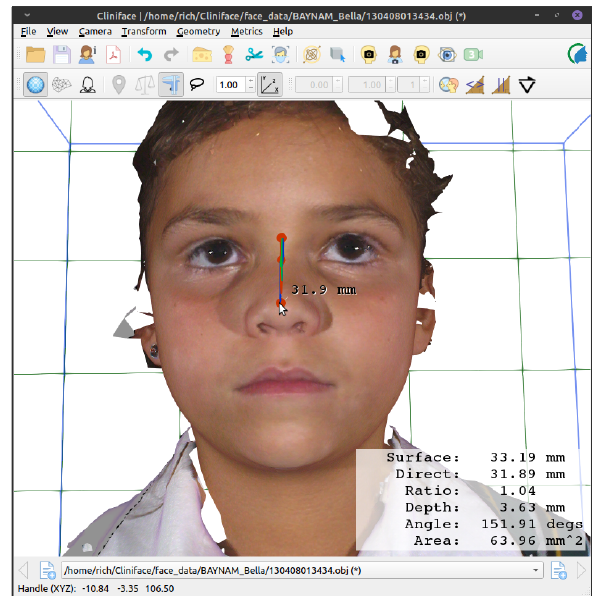
Figure 3. Cliniface ’s user interface during interactive placement of the nasal bridge